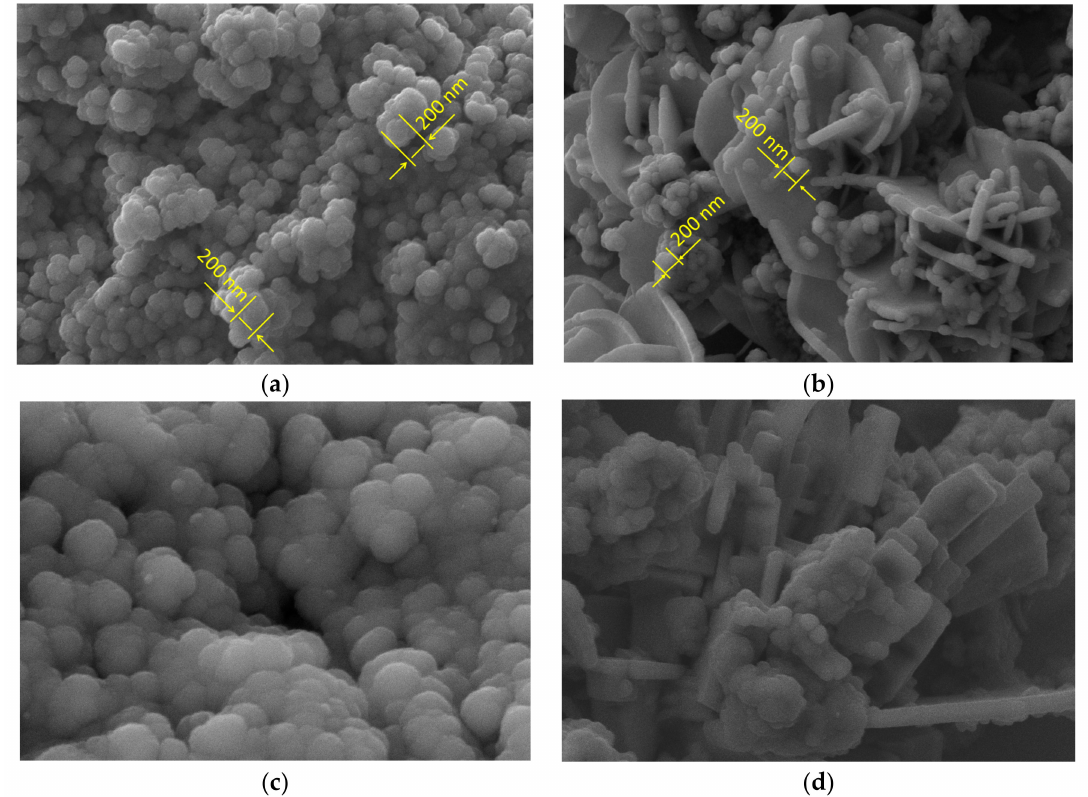
Figure 4. SEM images of the initial catalyst particles ( a ), and after experiments at 6 h